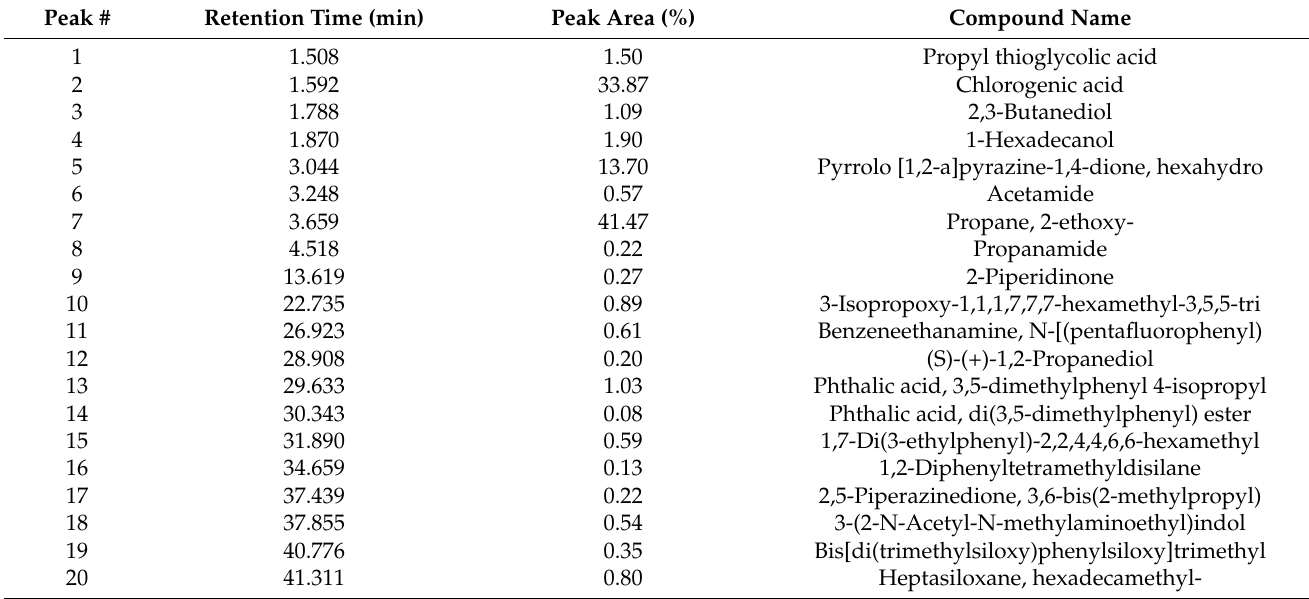
Figure 3. GC–MS chromatogram showing secondary metabolites produced by Bacillus subtilis SR22. Arrows show peak limits. Table 1. Secondary metabolites of Bacillus subtilis SR22 as detected by GC-MS system.